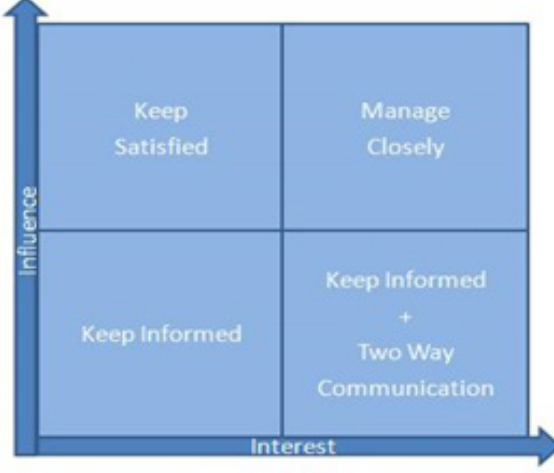
Fig. 6. Stakeholder Approach